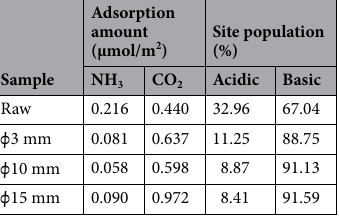
Table 1. Observed adsorption amount of NH 3 /CO 2 and estimated acidic/basic sites population on raw and mechanochemically activated HAp